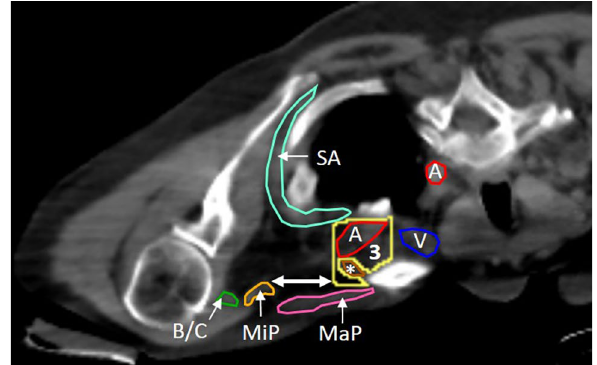
Figure 3. Adaptations to level III borders indicated on patient CT scan taken in PCP. The figure shows the first cranial slice where the axillary/subclavian artery first crosses both the lateral border of the first rib and the clavicle. In the most cranial slices of level III, the minor pectoral muscle can still be located (very laterally) close to its insertion on the coracoid process of the scapula. To spare the (up to 30 mm) margin indicated by the double arrow, the lateral border is taken at the lateral edge of the axillary artery until the artery crosses the medial edge of the minor pectoral muscle. Also note that the CTV excludes the subclavius muscle. Turquoise (SA) = serratus anterior muscle, red (A) = common carotid artery, or axillary/subclavian artery, yellow (3) = level III, blue (V) = subclavian vein, brown (*) = subclavius muscle, orange (MiP) = minor pectoral muscle, dark green (B/C) = biceps/coracobrachial muscle bundle, pink (MaP) = major pectoral